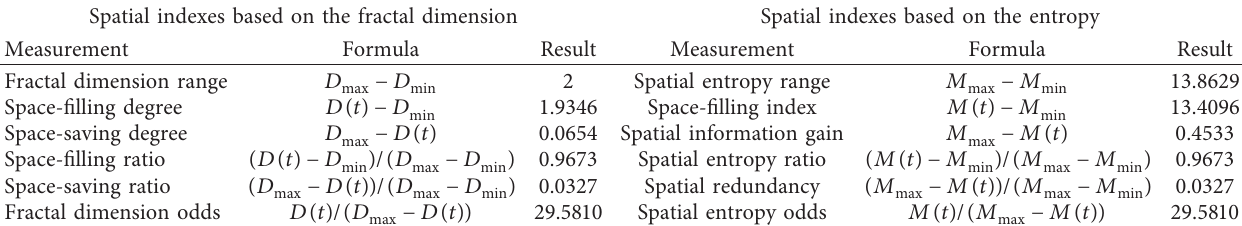
Table 5: Spatial measurement results based on the spatial entropy and fractal dimension of Beijing’s urban form (2015). Spatial indexes based on the fractal dimension